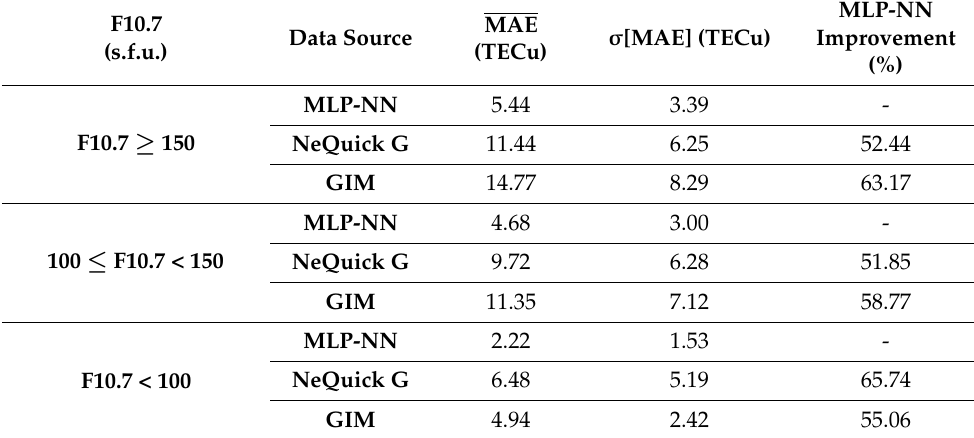
Table 2. Evaluation of the accuracy of the methods for different ranges of solar flux.